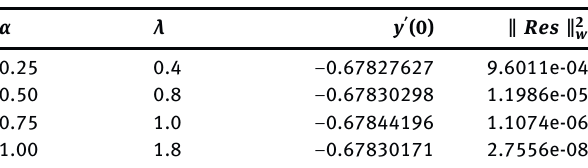
(a) Graph of residual error